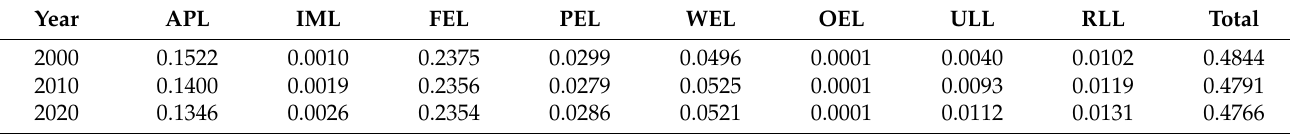
Table 4. EEQ index of different